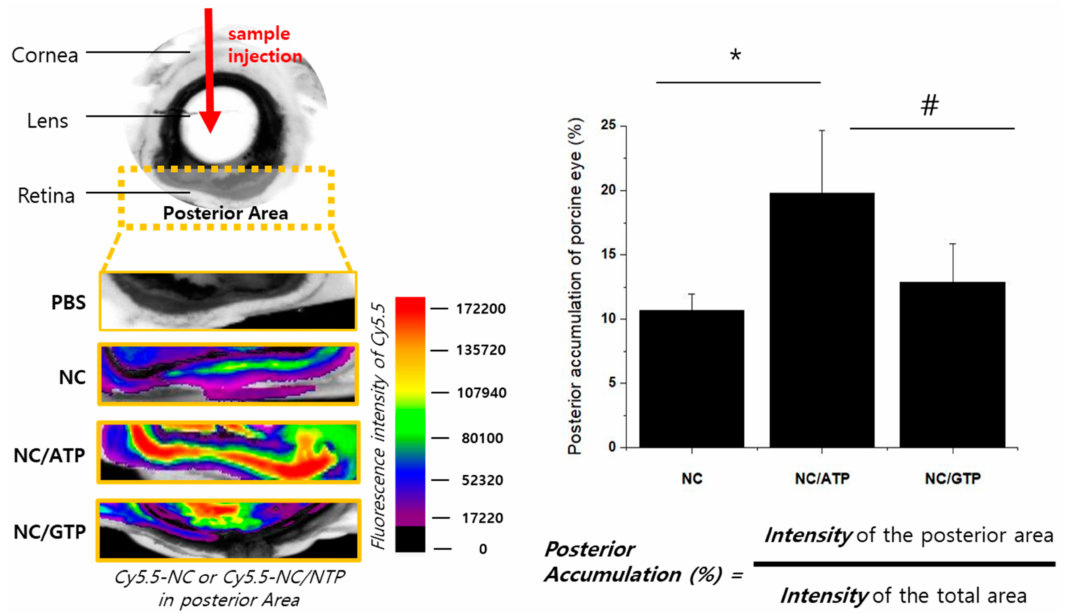
Figure 3. Ex vivo Cy5.5–NC or Cy5.5–NC–negatively charged ATP (NTP) distribution in porcine eyes and accumulated amount on the posterior area ( n = 3). The fluorescence of Cy5.5 was measured by a fluorescence imaging system. Statistical analysis by t -test: *: p ≤ 0.05; #: p >